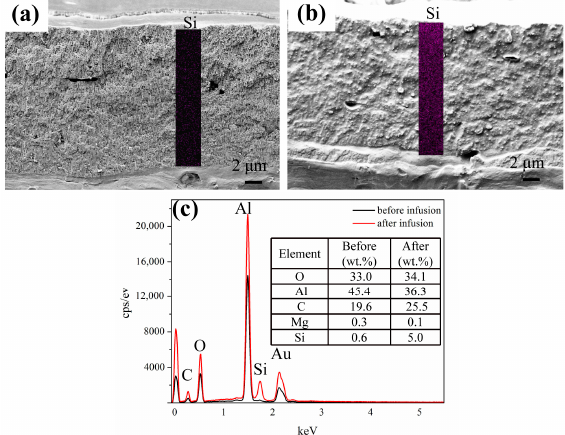
Figure 3. Cross-section of AAO before ( a ) and after ( b ) infusion of the silicone oil. The inset shows the EDS mapping images of silicon. ( c ) EDS spectra of the cross-section of AAO before and after infusion of 200 mPa · s silicone